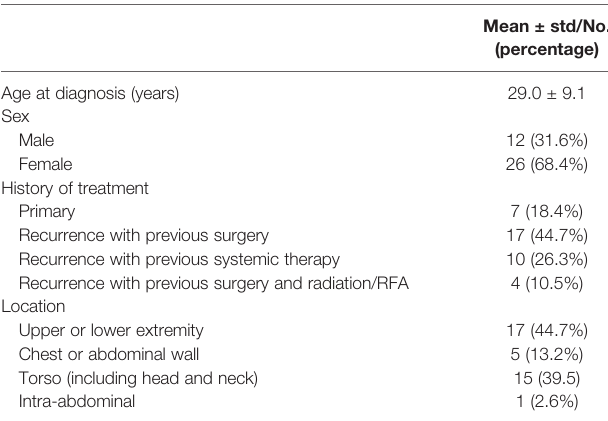
TABLE 2 | Patient